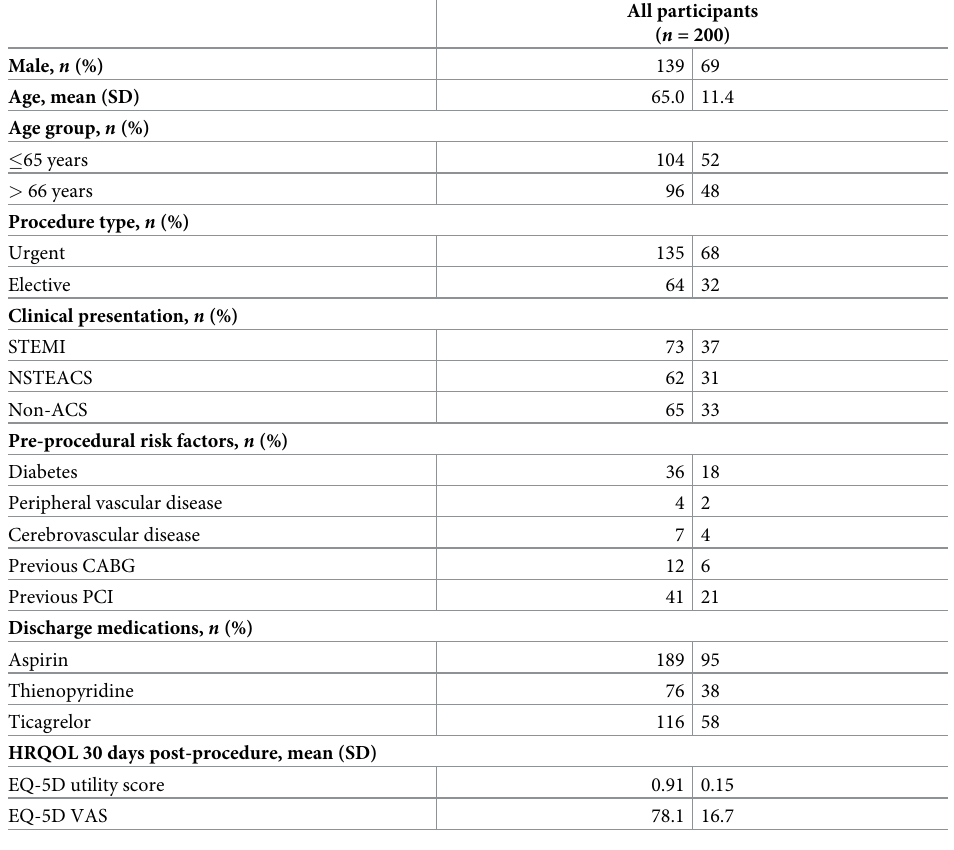
Table 2. Characteristics of participants following PCI